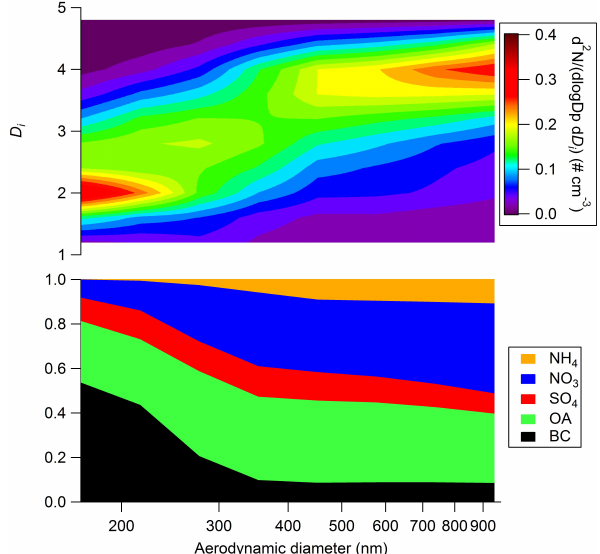
Figure 3. Campaign-averaged dependence of particle number con- centration on ATOFMS-derived single particle diversity ( D i , counts normalised per size bin) and particle diameter (top panel) and campaign-averaged dependence of ATOFMS-derived estimated sin- gle particle composition on particle diameter (bottom panel).